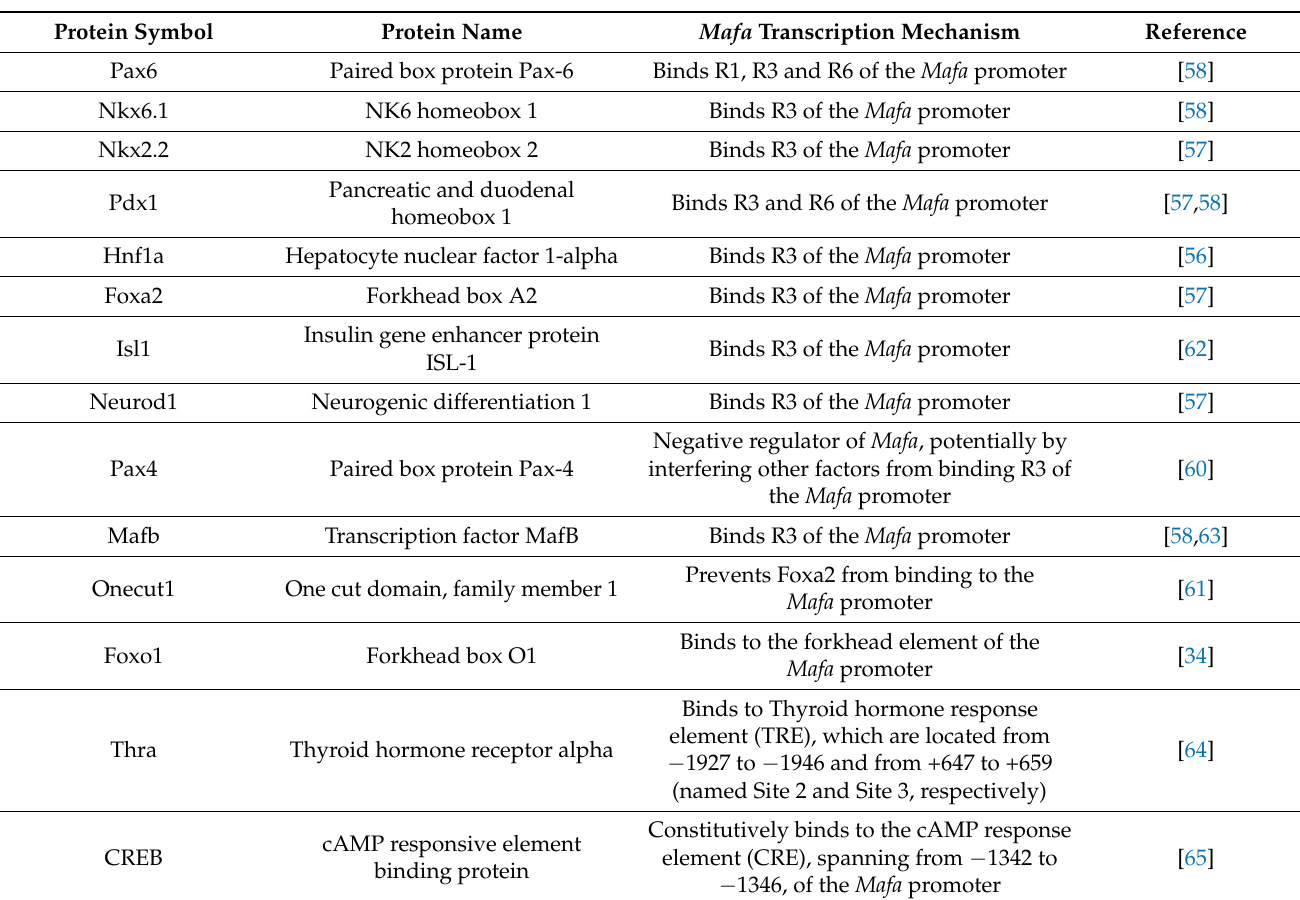
Table 2. Known transcriptional regulators of Mafa gene